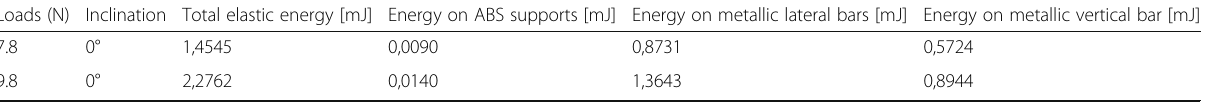
Table 1 Elastic strain energy calculation after application of two traction intensities tested (7.8 and 9.8 N) with an inclination of 0° with respect to the occlusal